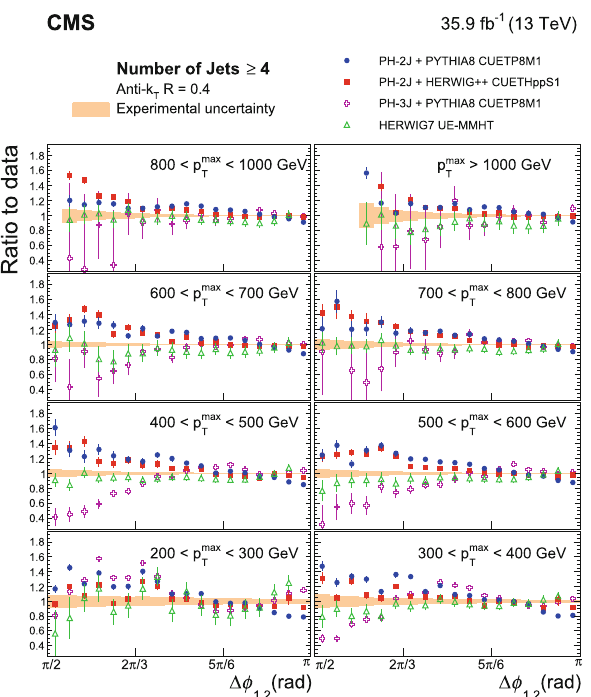
Fig. 9 Ratios of ph- 2j + pythia 8, ph- 2j + herwig++ , ph- 3j + pythia 8, and herwig 7 predictions to the normalized inclusive 4- jet cross section differential in Δφ 1,2 , for all p max band indicates the total experimental uncertainty and the vertical bars on the points represent the statistical uncertainties in the simulated data